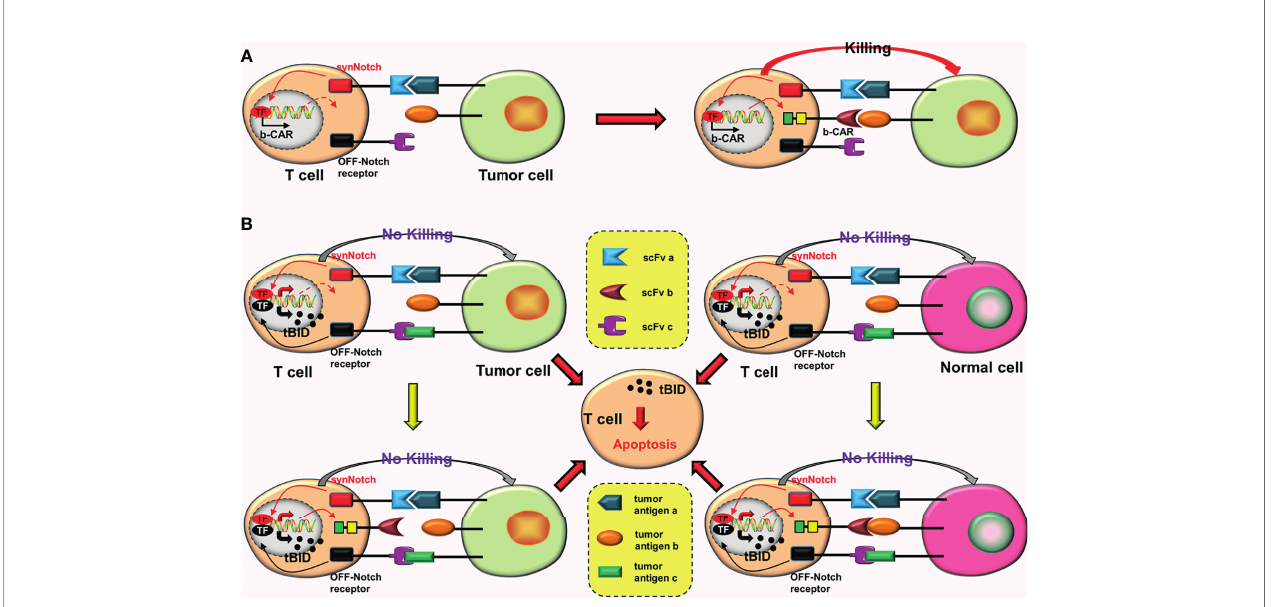
FIGURE 6 | AND-NOT CARs. (A) The synNotch receptor binds to the corresponding tumor antigen (a), causing the expression of b-CAR genes. Subsequently, the newly expressed b-CAR binds to the target antigen (b). Finally, the CAR-T cell is activated. (B) The binding of the OFF-Notch receptor to the corresponding antigen (c) induces the expression of tBID, regardless of whether b-CAR is formed and whether it binds to the corresponding tumor antigen. Apoptosis of the CAR-T cell can be induced by the